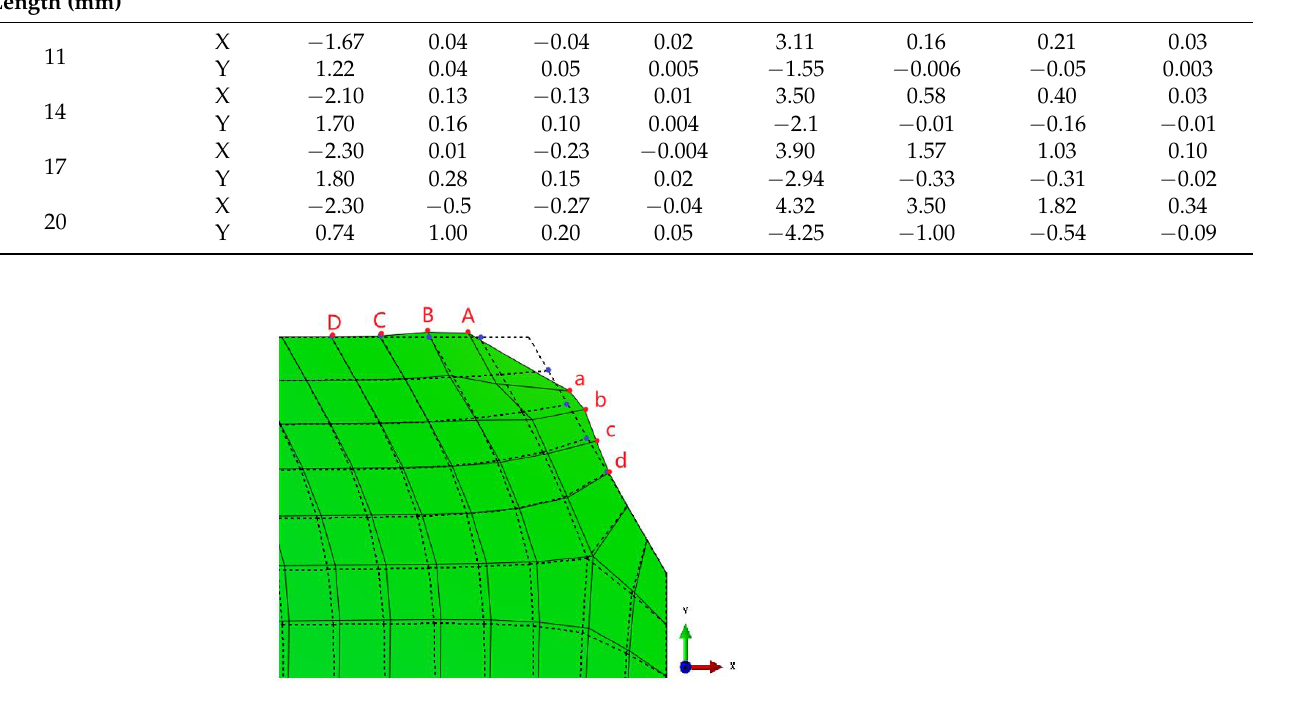
Figure 13. Deformation morphology of the slab corners under vertical rolling with a chamfered length of 20 mm.